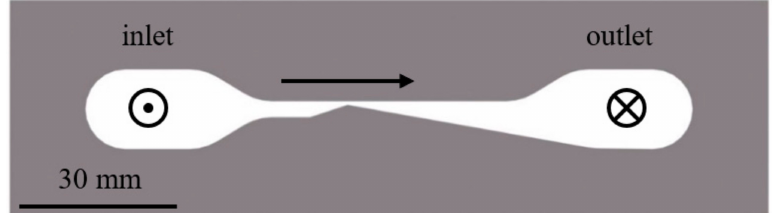
Figure 1. Microchannel geometry with the 675 µ m throat gap and the 450 µ m channel width.